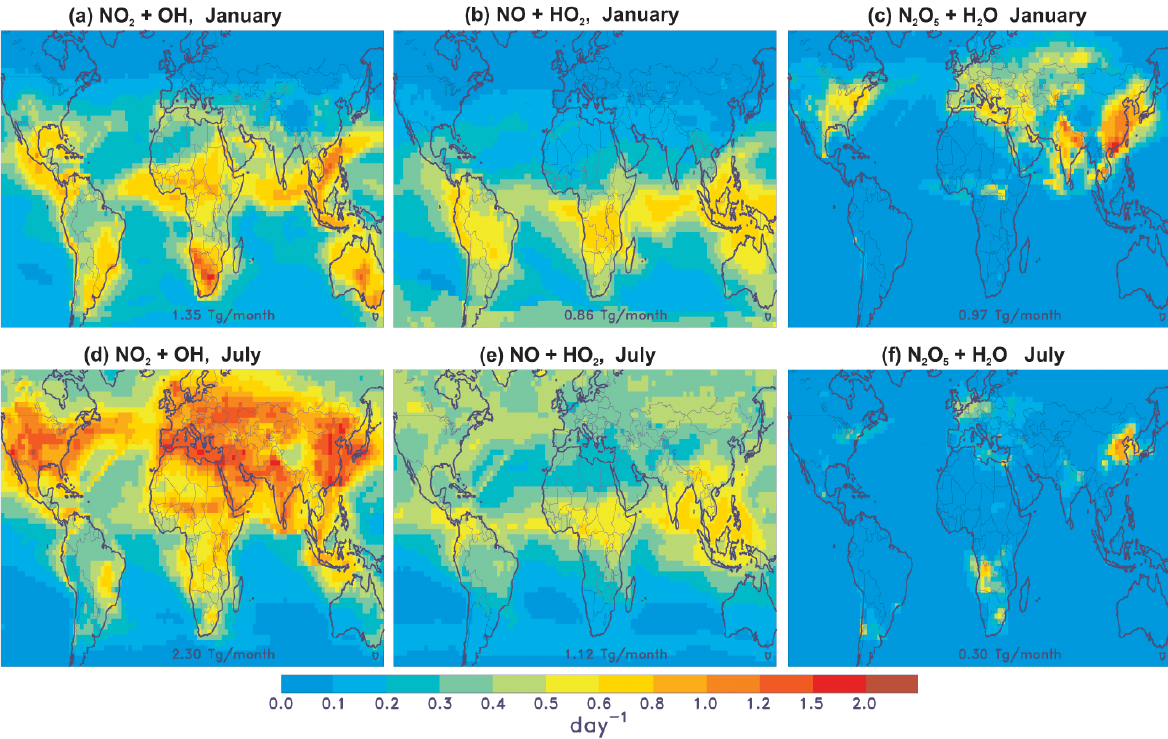
Fig. 5. Calculated contribution of (a, d) NO 2 +OH reaction, (b, e) the HNO 3 -forming channel in NO+HO 2 reaction, and (c, f) the heteroge- neous N 2 O 5 sink to the tropospheric NO x sink rate (day − 1 ) in January (a–c) and July (d–f) for the MAXLOSS